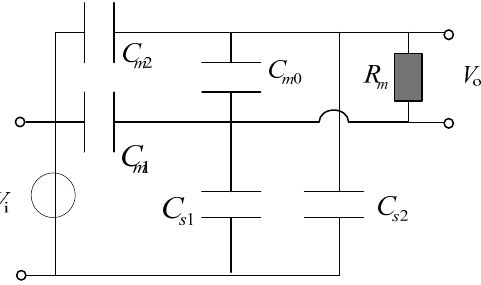
Figure 4. Equivalent circuit of the probe and passive